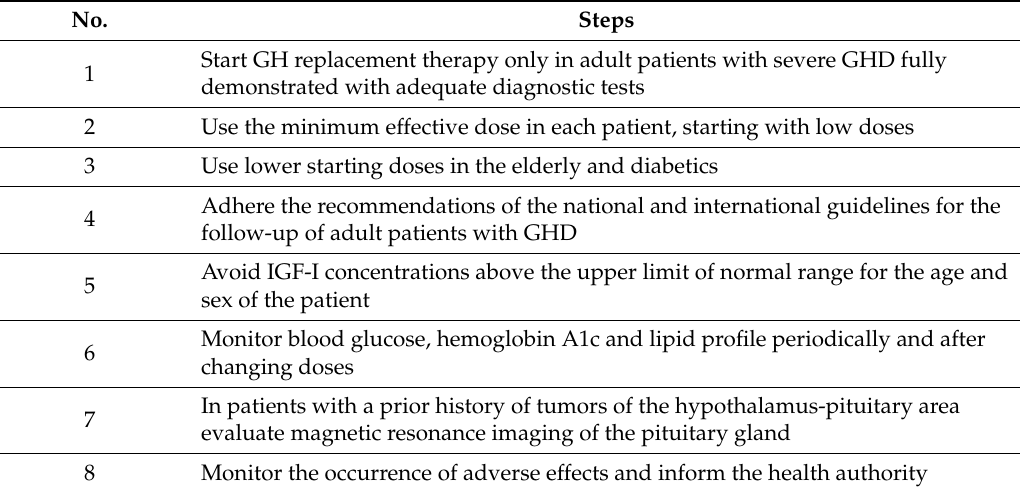
Table 2. General recommendations for the treatment with GH in adults with